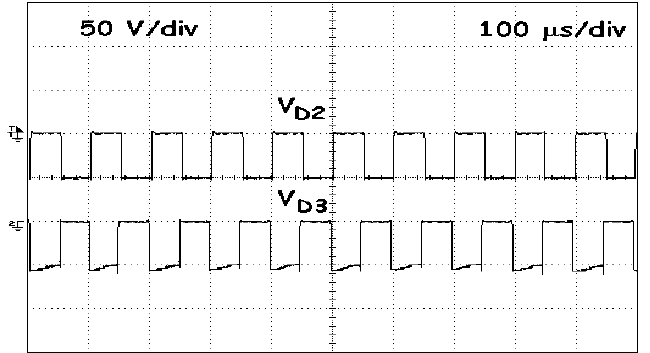
Figure 19. Experimental results for the voltage across the diodes D 2 and D 3 in buck mode.